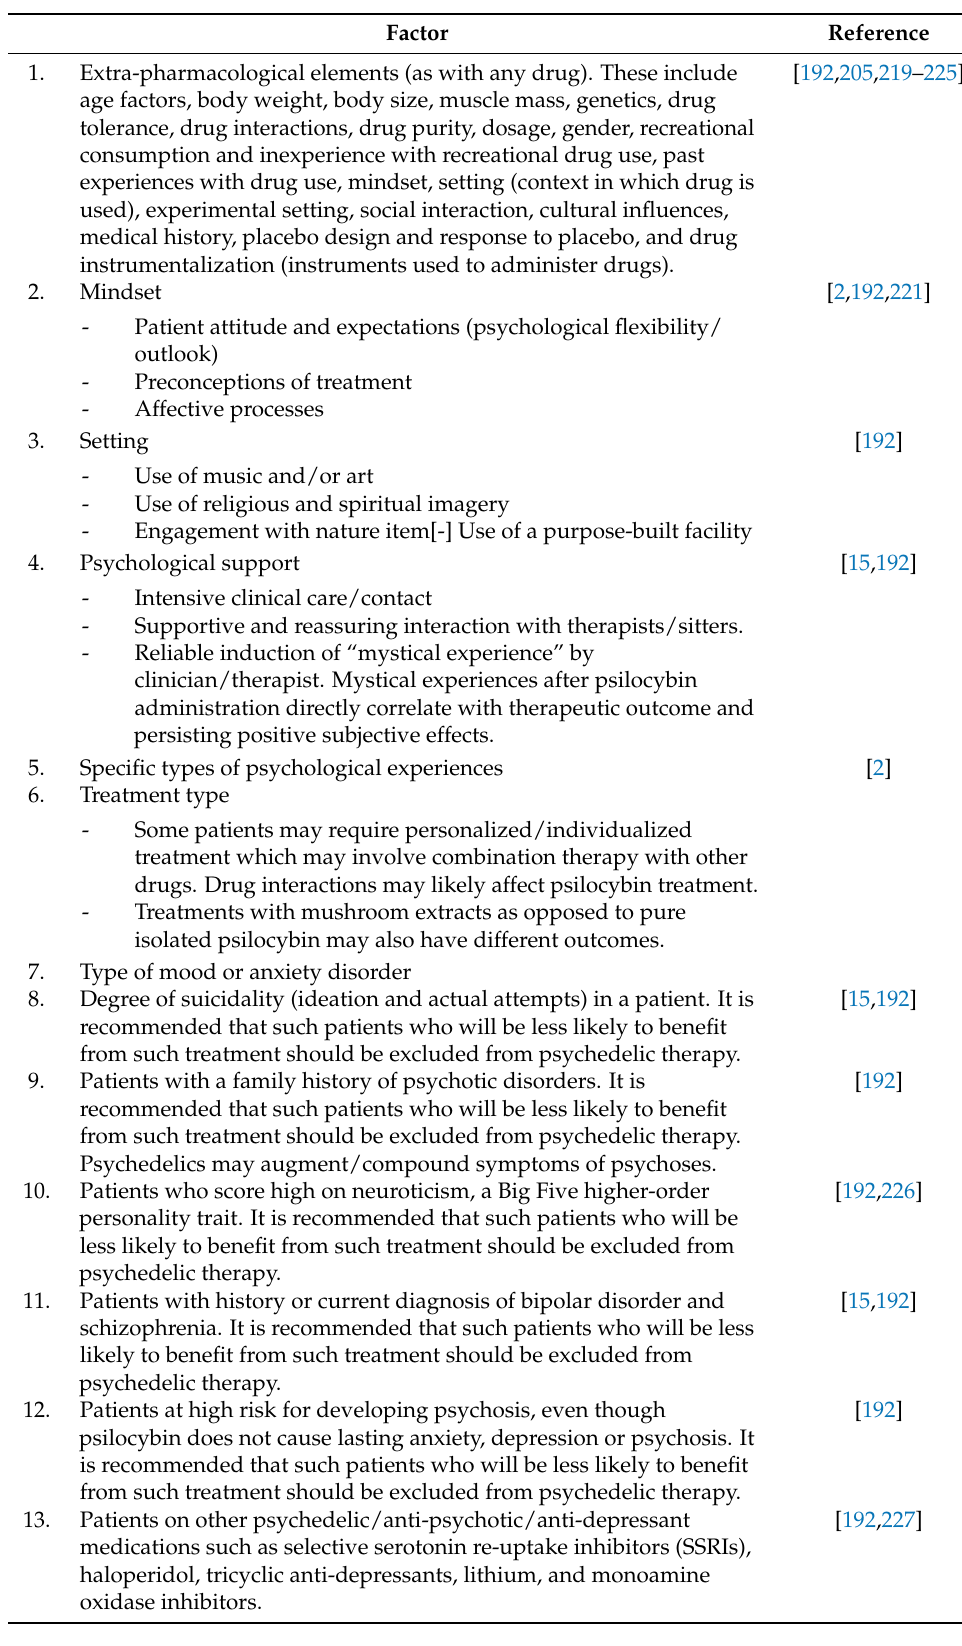
Table 6. Factors that affect therapeutic/clinical outcome of psilocybin administration. Factor